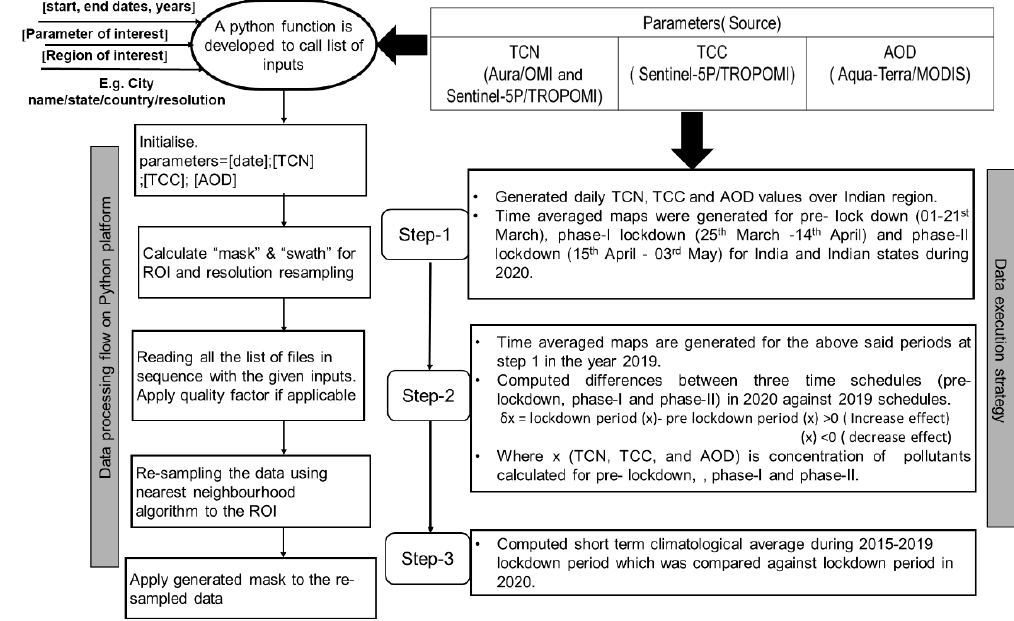
Figure 1. Data processing steps and